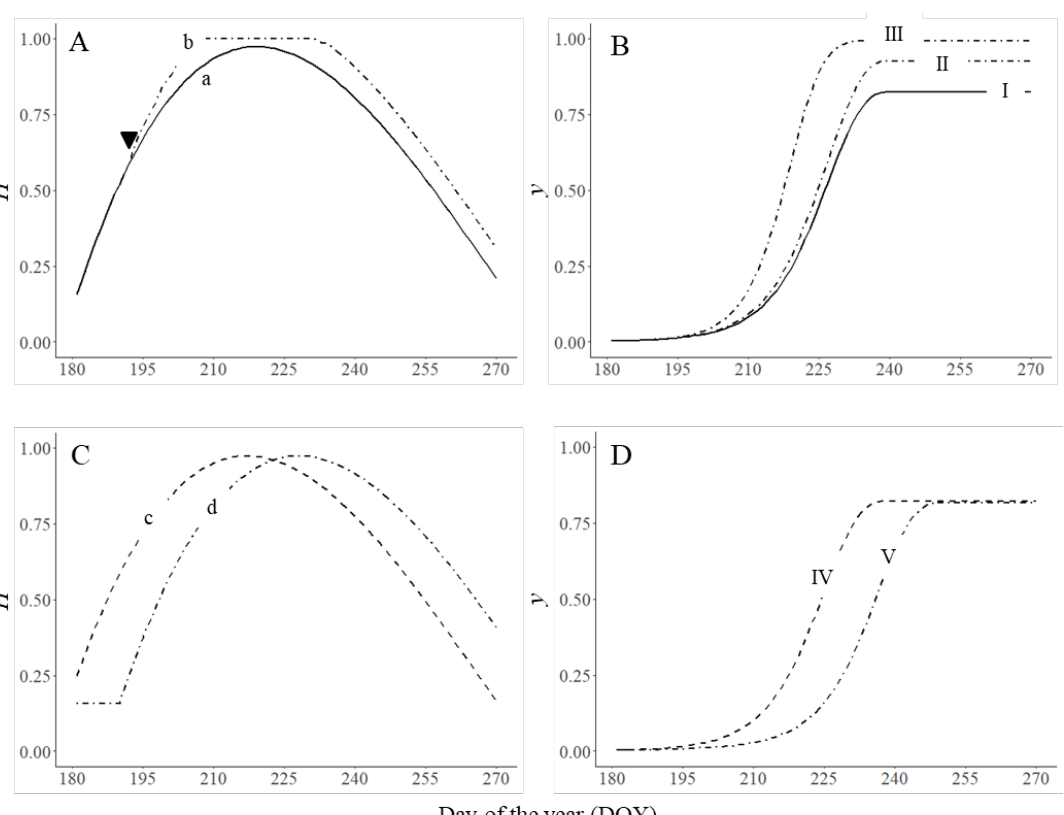
Figure 4. E ff ect of changes in plant growth ( H ; A , C ) on disease severity ( y ; B , D ). ( A ) a: H (cid:48) as in Figure 2: Figure 4. Effect of changes in plant growth (H; A and C ) on disease severity ( y ; B and D ). ( A ) a: H’ as H = 8.1582 x 1.4483 ( 1 − x ) 1.6081 , being x is the equivalent of the day of the year (DOY) in the form x = in Figure 2: 𝐻 = 8.1582𝑥 1.4483 (1 − 𝑥) 1.6081 , being x is the equivalent of the day of the year (DOY) in (DOY − 170) / (280 − 170); b: H (cid:48) increased beginning with DOY 193 ( (cid:72) ). ( B ) I: untreated control as in the form x = (DOY − 170)/(280 −170); b: H’ increased beginning with DOY 193 ( ▼ ). ( B ) I: untreated Figure 2 ( N = 0.8, I = 0.8, p = 6, i = 12, H (cid:48) = a); II: epidemic for H (cid:48) = b; III: H (cid:48) = b and model parameters control as in Figure 2 ( N = 0.8, I = 0.8, p = 6, i = 12, H’ = a); II: epidemic for H’ = b; III: H’ = b and model change to N = 0.9, I = 0.9, p = 5, i = 14. ( C ) c: H (cid:48) modified by sowing a short-cycle plant variety; d: H (cid:48) parameters change to N = 0.9, I = 0.9, p = 5, i = 14. ( C ) c: H’ modified by sowing a short-cycle plant modified by delaying sowing date. ( D ) IV: epidemic for H (cid:48) = c; V: epidemic for H (cid:48) = d. Symbols are variety; d: H’ modified by delaying sowing date. ( D ) IV: epidemic for H’ = c; V: epidemic for H’ = d. listed in Table Symbols are listed in Table 1.